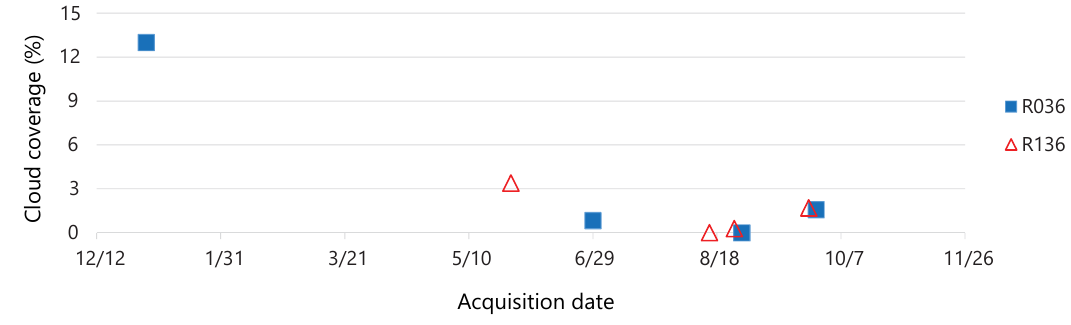
Figure 3. Acquisition dates and the percentage of cloud coverage (CC) for the selected Sentinel-2A images in the crop thematic mapping. Data correspond to images with small CC from two adjacent relative orbits of Sentinel-2A in 2016, i.e., time series R036 and R136. Since the winter wheat harvest season in Serbia usually starts in the beginning of June, and in R036 were no cloud free acquisitions before the end of the June, in order to improve winter wheat classification R036 also includes one snow-free image from the winter period.